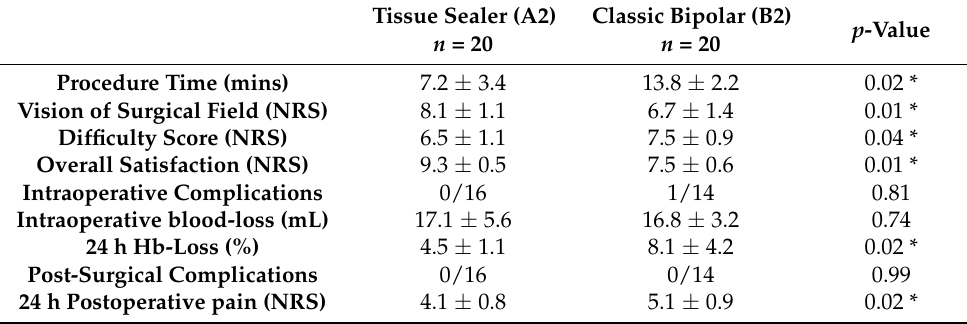
Table 3. Primary and secondary outcomes for laparoscopic